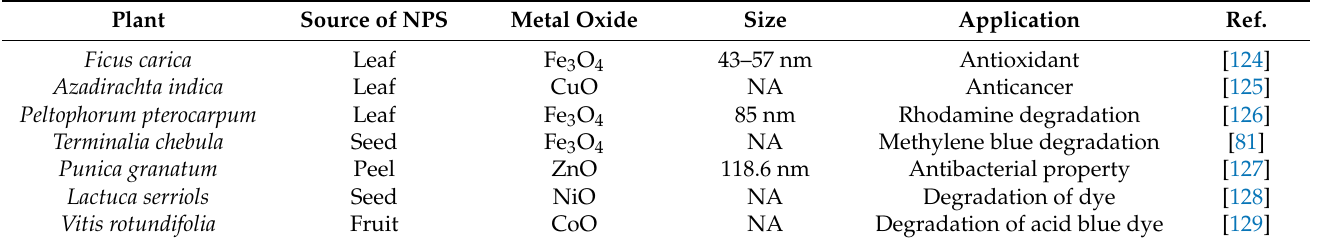
Table 2. List of some MO x NPs synthesized from different plant samples with numerous applica- tions [119].